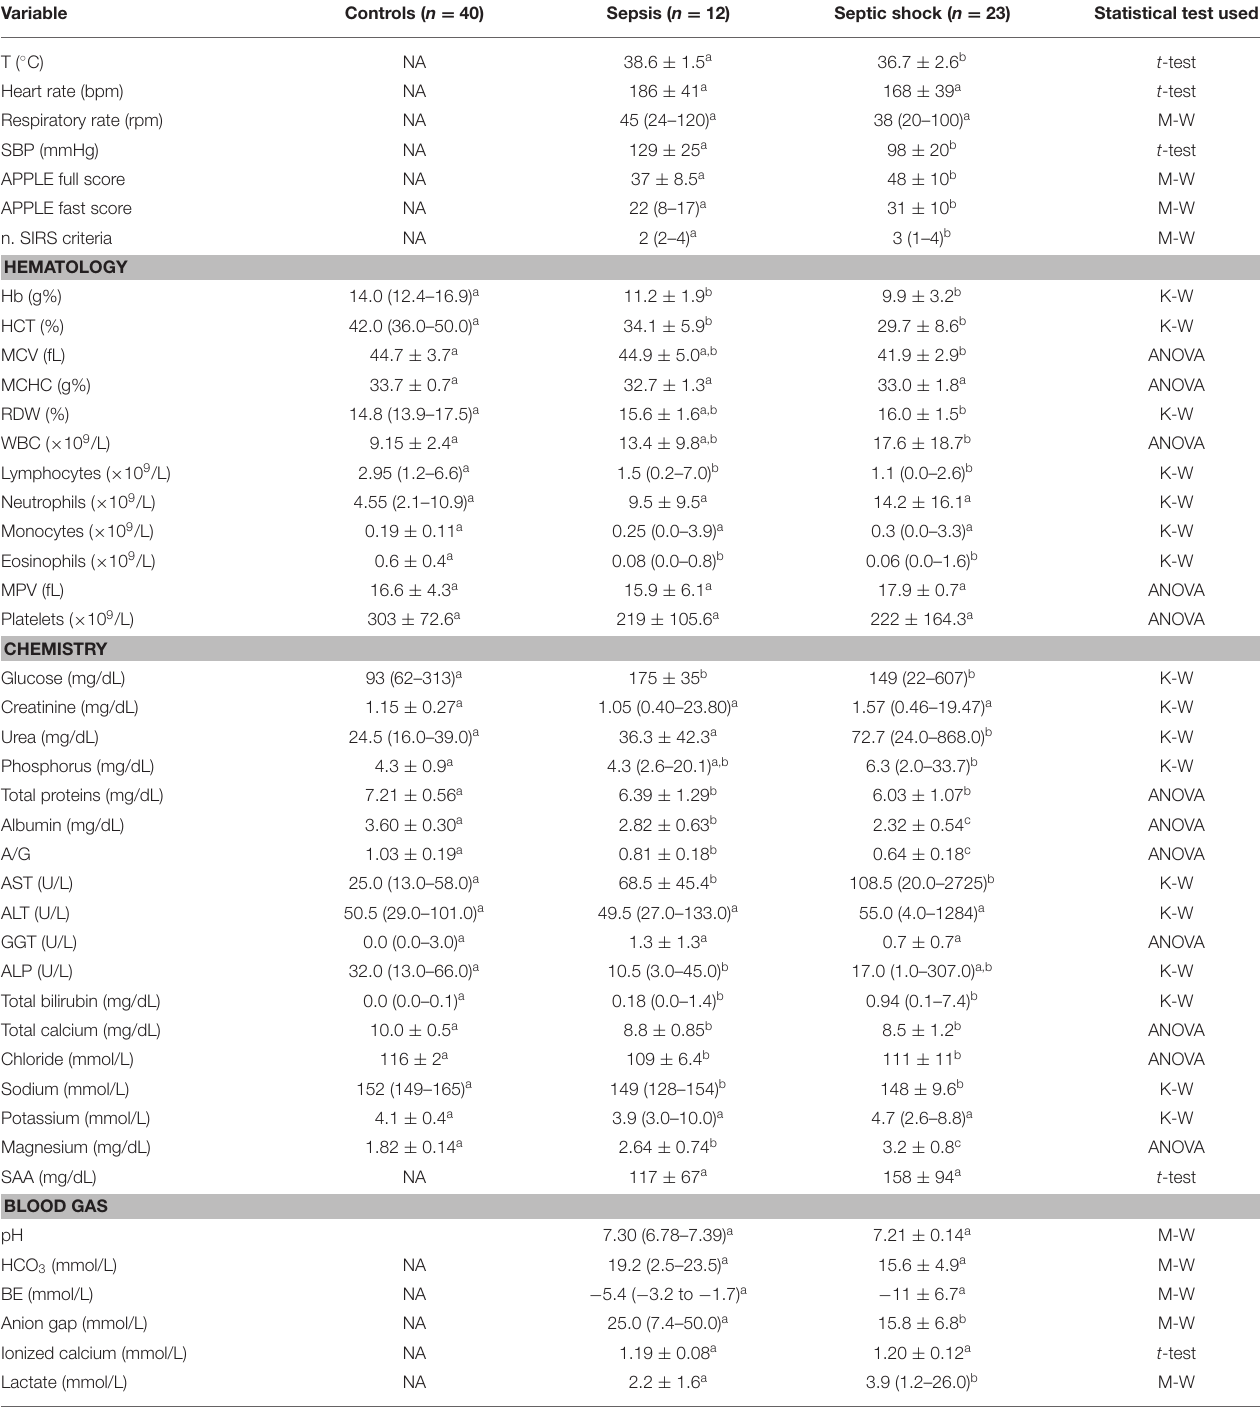
TABLE 1 | Results of descriptive statistics for selected clinical and clinicopathological variables in cats with sepsis and septic shock.